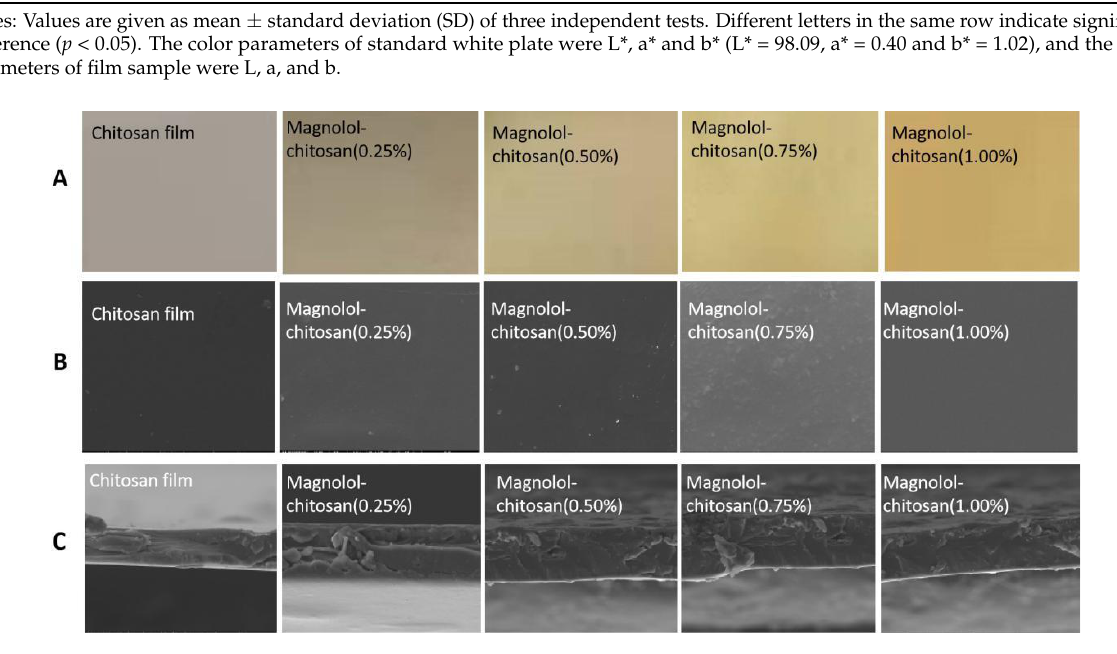
Figure 2. Photographs ( A ) and ESEM micrographs of surface ( B ) and cross-section ( C ) of chitosan films without and with different contents of magnolol.